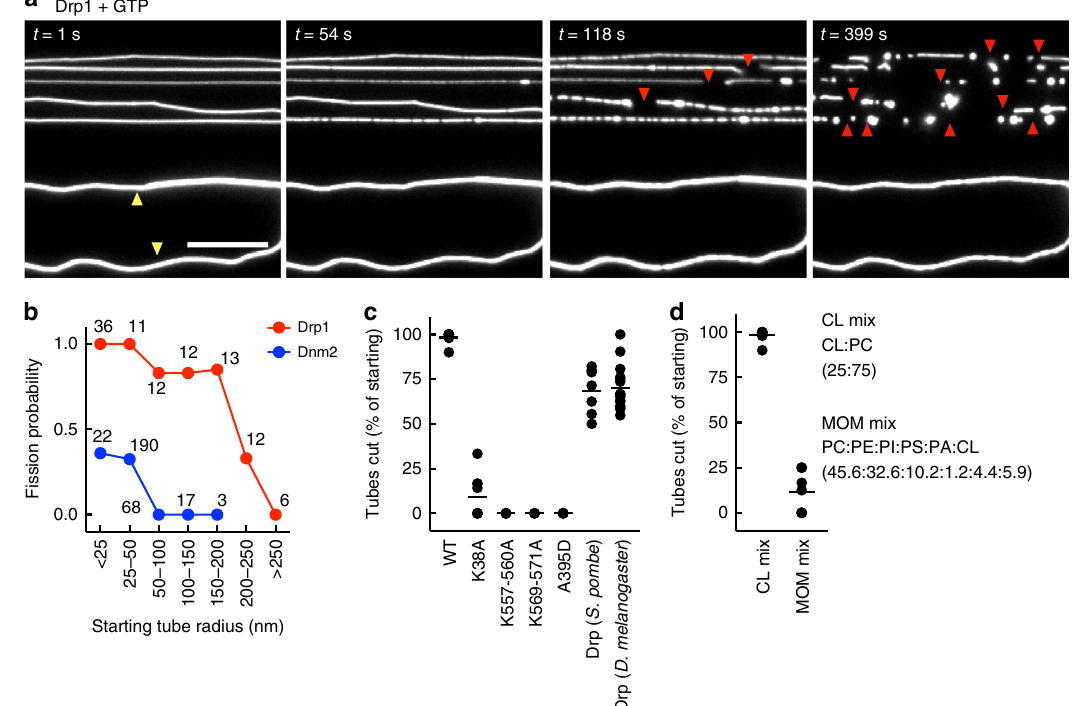
Fig. 6 Drp1- and Dnm2-catalyzed membrane fi ssion. a Frames from a time-lapse movie showing Drp1-catalyzed fi ssion. Red arrowheads mark site of fi ssion, yellow arrowheads mark tubes that remain uncut. Scale bar = 10 µ m. b Fission probability with Drp1 and Dnm2 as a function of starting tube radius. n (tubes) for each size range is indicated in the plot. c Analysis of Drp1-catalyzed fi ssion with the indicated mutants and orthologs. n (WT) = 10, n (K38A) = 11, n (K557 – 560A) = 5, n (K569 – 571A) = 3, n (A395D) = 6, n (Drp S. pombe ) = 7, and n (Drp D. melanogaster ) = 16 microscope fi elds of a single experiment where each fi eld displayed 30 – 35 tubes. d Analysis of Drp1-catalyzed fi ssion on templates of the indicated lipid composition. n (CL mix) = 8 and n (MOM mix) = 7 microscope fi elds from a single experiment where each fi eld displayed 30 – 35